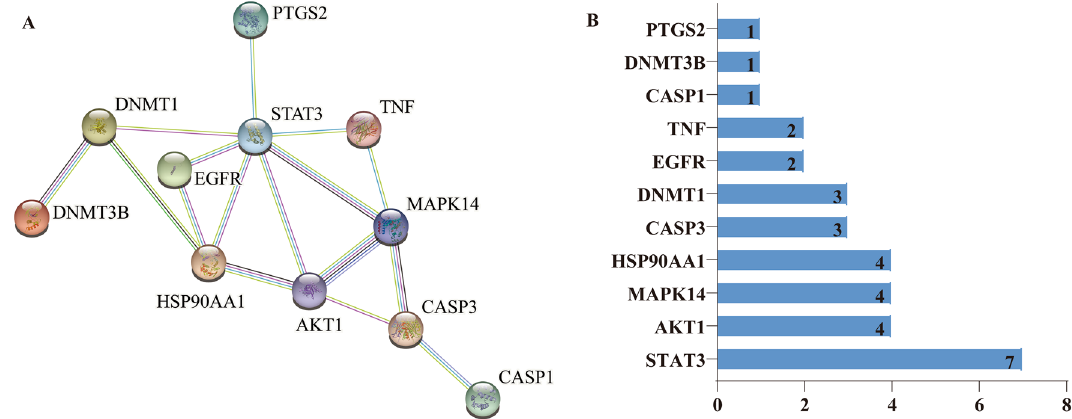
Figure 6. Protein–protein interaction Network. ( A ) PPI network. ( B ) The degree value of the targets.